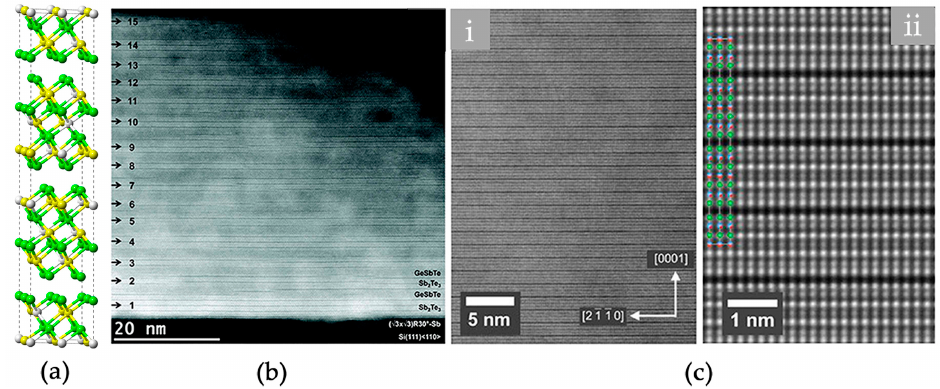
Figure 3. ( a ) The atomic model of hexagonal Ge 1 Sb 2 Te 4 . Chemical disorder is included for the cationic-like layers. Ge, Sb and Te atoms are rendered with grey, yellow and green spheres, respectively; ( b ) The HAADF-STEM image of hexagonal Ge 1 Sb 2 Te 4 , which was obtained by annealing a molecular beam epitaxy (MBE) grown sample at 400 °C for 30 min; ( c ) The HAADF-STEM images of hexagonal Ge 1 Sb 2 Te 4 , which was produced by metal organic vapor phase epitaxy (MOVPE) method with a growth temperature above 400 °C. The brighter dots indicate Te atomic columns, whereas darker dots are Ge/Sb atomic columns. Adapted with permission from References [66,67] © 2015 The Royal Society of Chemistry; 2016 Elsevier Ltd.